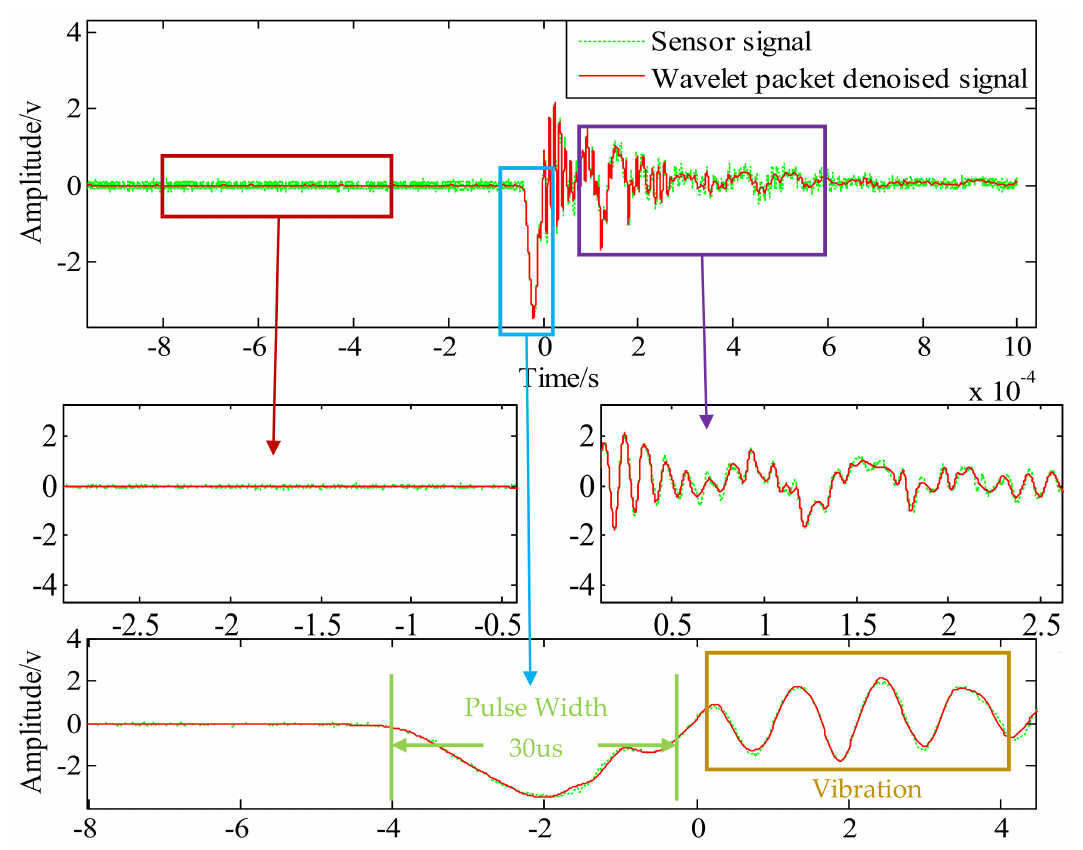
Figure 12. Test signal before and after wavelet packet threshold denoising.